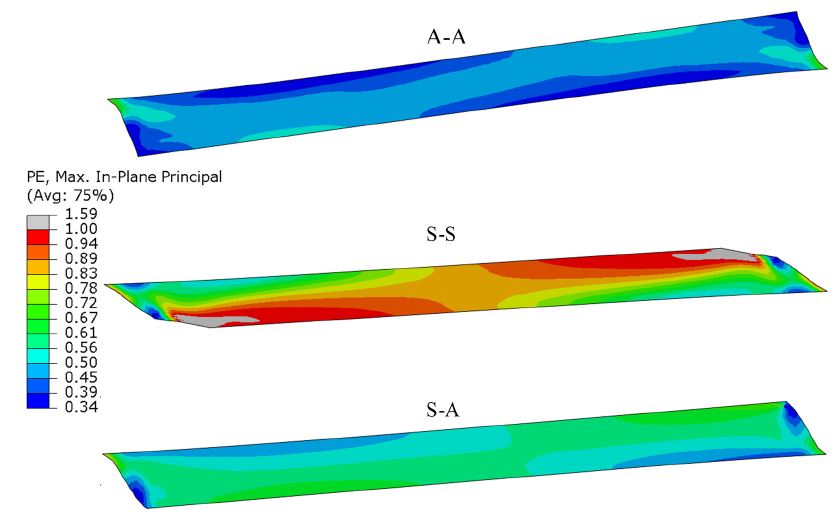
Figure 22. Map of the plastic strain component in the layer of the adhesive. Stress distributions along the boundary of the element (flat bar), in the adhesive and in the